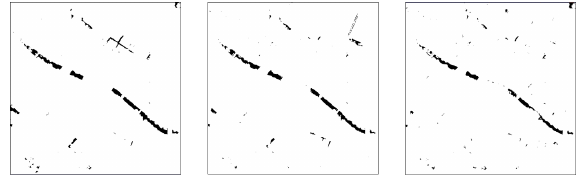
Figure 3. DSM − DTM exhibit at special areas disturbed elevation values, top profiles corresponds to line 1 (river), bottom profiles corresponds to line 2 (bridge). Color specifications are explained in the text.